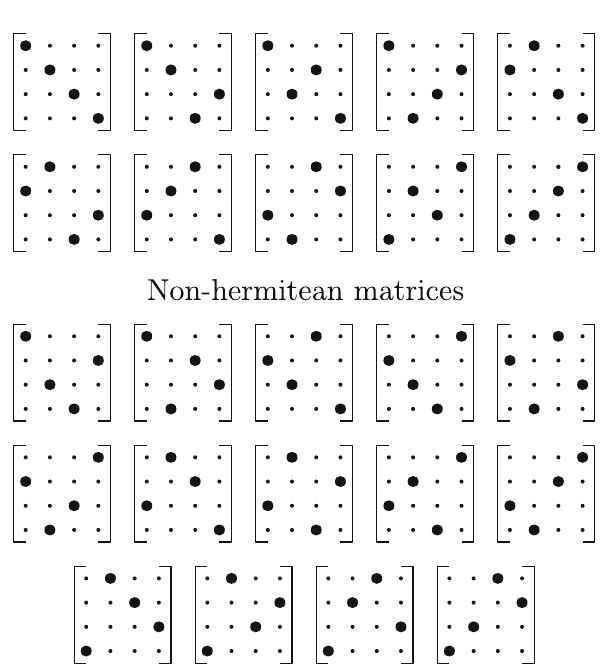
Fig. 1 Set of all binary and unitary matrices sized 4 × 4, divided into Hermitian and non-Hermitian matrices. The bigger dots stand for 1 and the smaller dots for 0